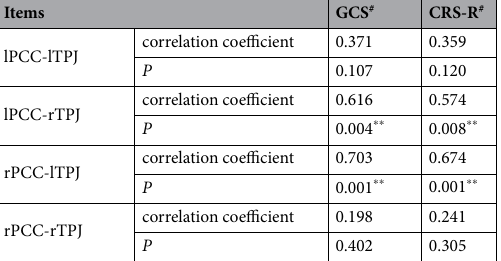
Table 3. Correlation Analysis of the Intra- and Cross-hemispheric Functional Connectivity Strengths with both the GCS # and CRS-R # scores. This table shows the statistical data corresponding to Fig. 4A,B. P.S.: GCS #